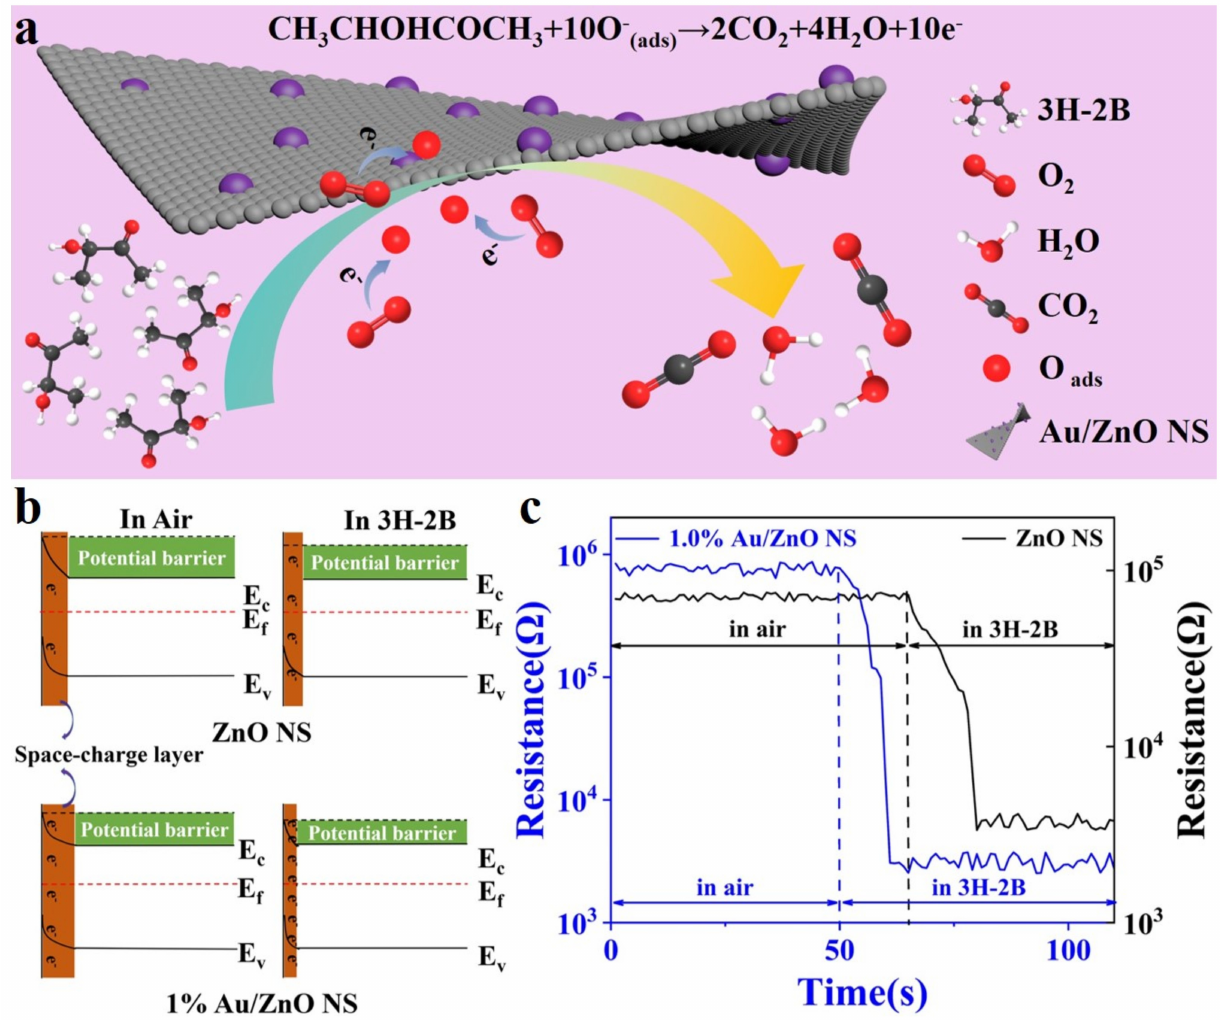
Figure 8. ( a ) The schematic illustration of 3H-2B sensing mechanism. ( b ) Electron structure change and ( c ) resistance change of ZnO NS and 1.0% Au/ZnO NS in air and